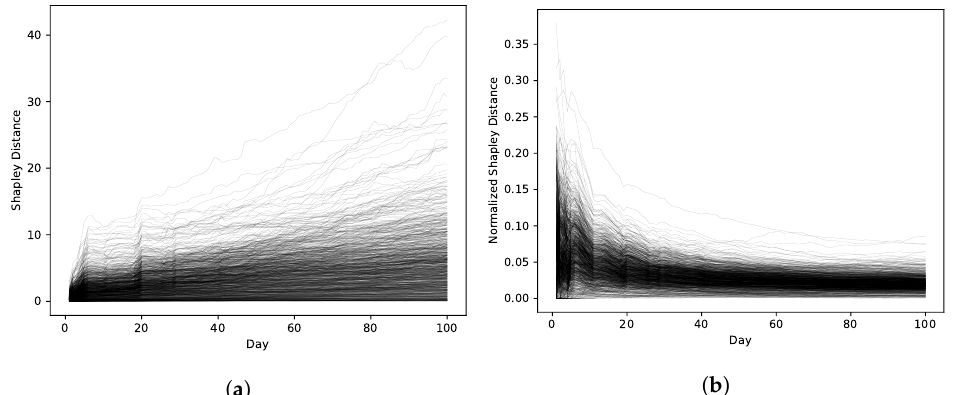
Figure 11. Progress of Shapley distance ( a ) and normalized Shapley distance ( b ) with Shapley–core for 1000 trials. Table 5. Numbers of trials with increasing, decreasing, and no trend in the Shapley distance and normalized Shapley distance between day 20 and 100 with Shapley–core. Trend Shapley Distance Normalized Shapley Distance Increasing 935 128 Decreasing 36 816